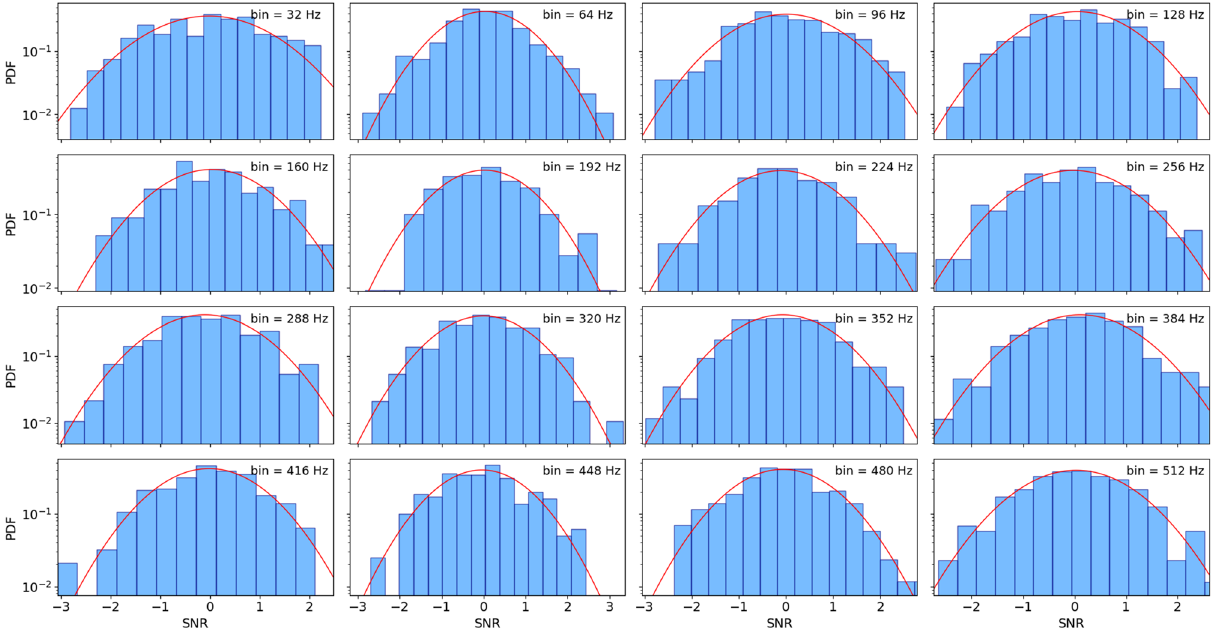
Figure 7. The results show PDF of normalized SNRs for each frequency bin. The total time duration of analysed time series is about 637 h. In each subgraph a Gaussian PDF with unit variance is plotted for indicators of chirp and spurious signals. Intuitively, this stems from the fact that in chirp signal in the chosen frequency band, all SNRs have finite values and their dispersion are small, however in spurious signal, some bins have high SNR and in other bins have smaller, then there is the high value of dispersion. To check the Gaussianity of SNRs in each frequency bin, we estimate the SNR for a random set of 560 captures from Hanford detectors during the O2 (from GPS Time 1164556817 to GPS Time 1187733618) and O3a (from GPS Time 1238166018 to GPS Time 1253977218) run 30,58 . The duration of each capture was 4096 s and data points were sampled at 4KHz. The total time duration was 637h. A list of the name of time series can be found at Supp. Mat. To estimate SNRs, we first applied a highpass filter with a frequency pass > 30 Hz. We assumed